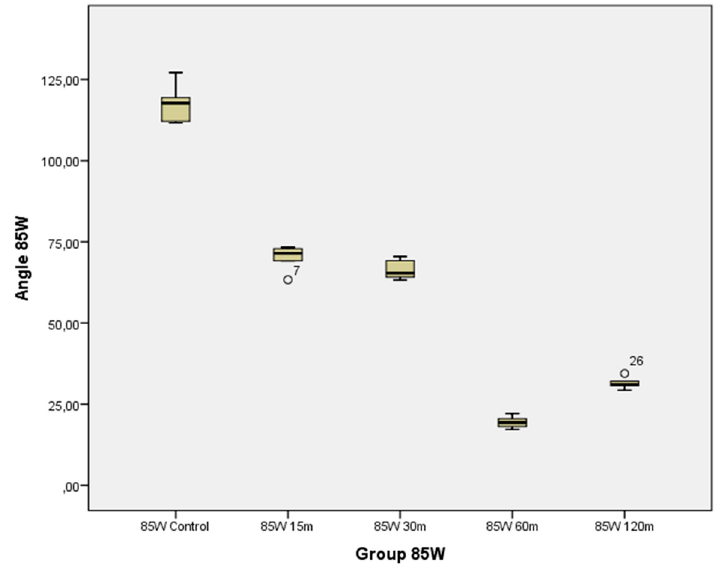
Figure 7. Box plot of angles obtained with an 85 W lamp at different irradiation times, including the control. The graphs show the lower (Q1), mean (Q2), and upper (Q3) quartiles. The whiskers represent the highest and lowest values. All the groups presented sta- tistically significant differences with respect to the control. The 60 and 120 min groups also showed statistically significant differences from the 15 and 30 min groups. Table 1. Data obtained with the 6 W lamp.